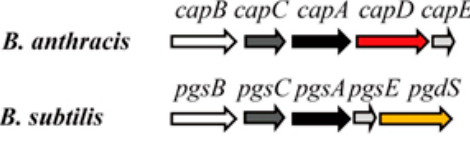
Figure 2. pgsBCA and capBCA gene clusters.